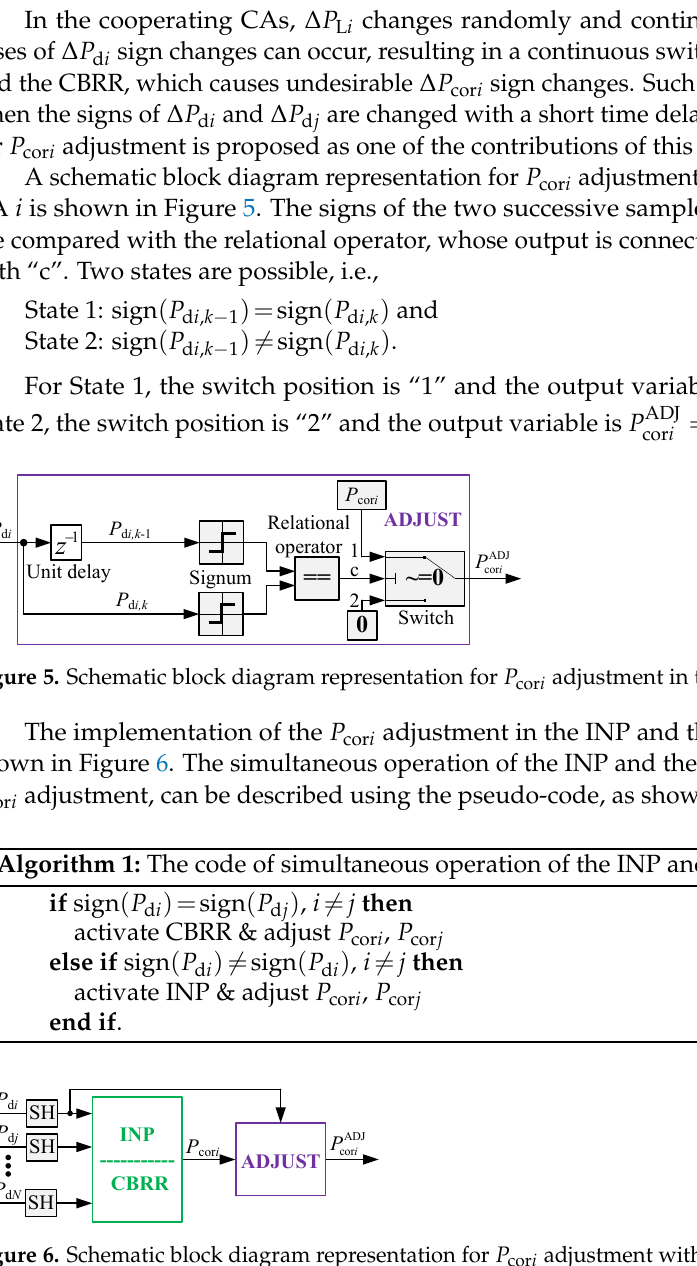
Figure 6. Schematic block diagram representation for P cor i adjustment with the INP and the CBRR in the CA i